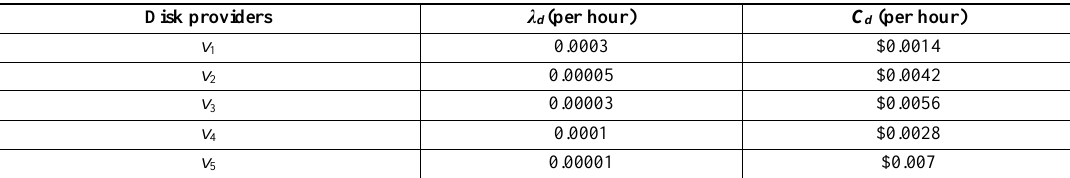
Table 1. Input parameters of cloud disk drives